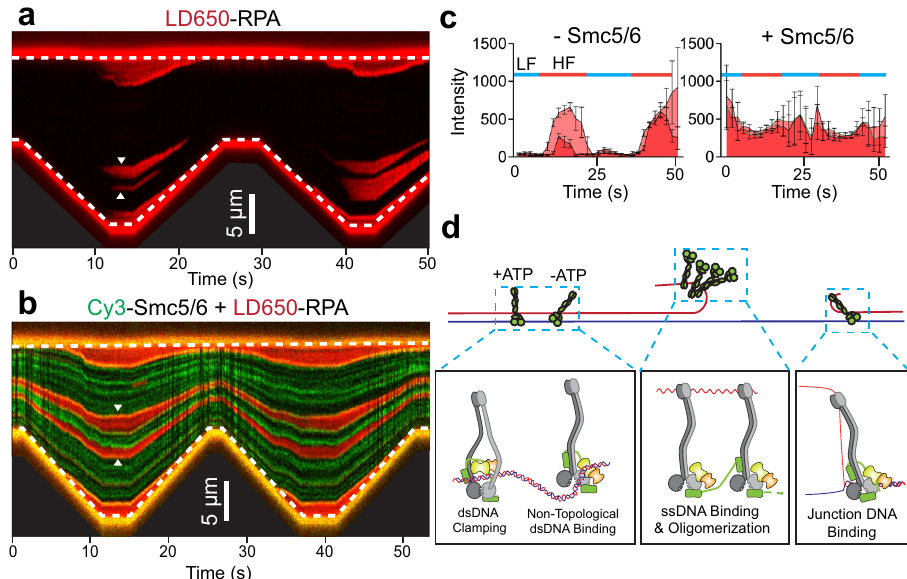
fl uorescence signals (from the individual streaks indicated by the white arrows in panels a and b )overtimeintheabsenceorpresenceofSmc5/6.LFandHFregimes are indicated byblue and red bars, respectively. Data points indicate the averaged photon count per frame( n =10 frames) ofa regionalong the RPAstreakand error bars represent standard deviation. Source data are provided within the Source Data fi le. d ( Top ) Summary of the different Smc5/6 binding behaviors on DNA observed in our study. ( Bottom ) Working model for Smc5/6 binding modes on different types of